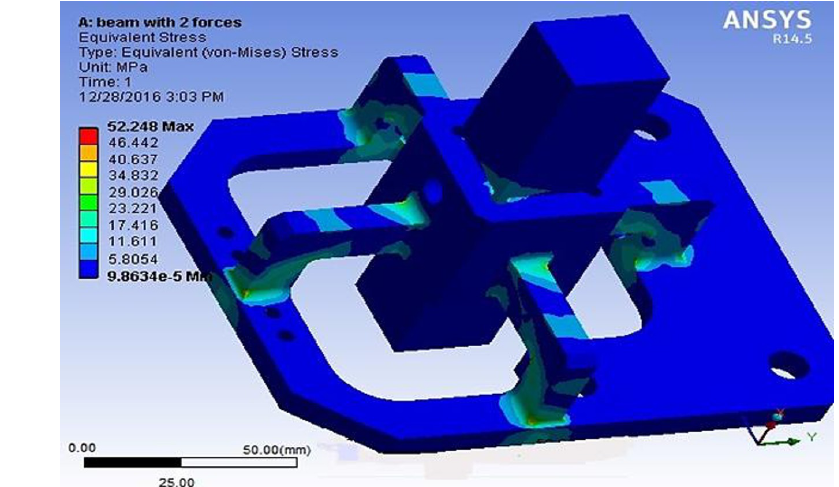
FIG. 1. VON MISES STRESS